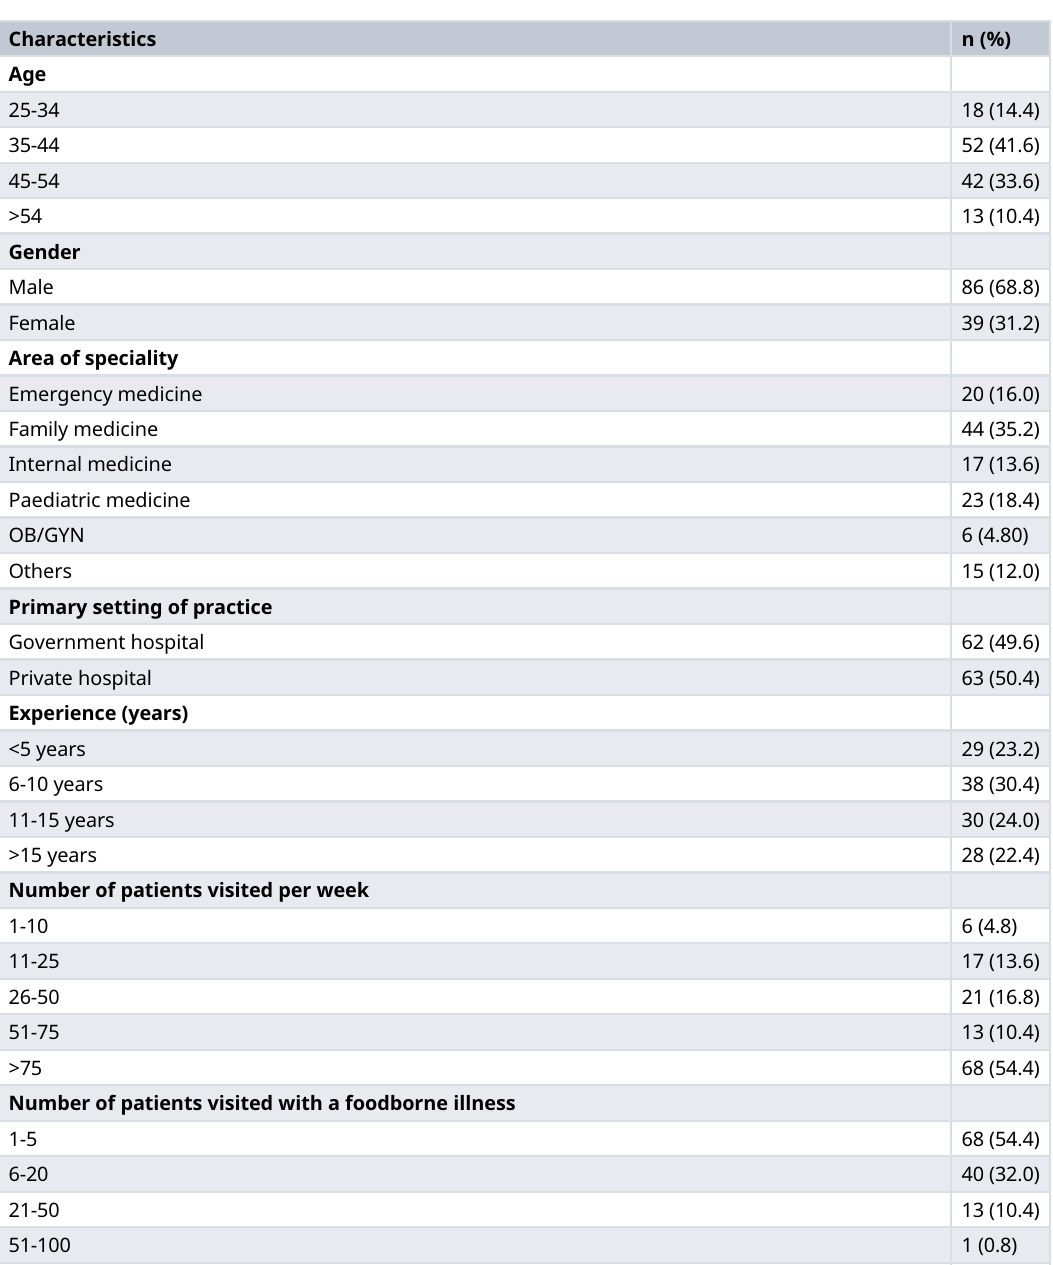
Table 1. Demographic characteristic of study participants (n =